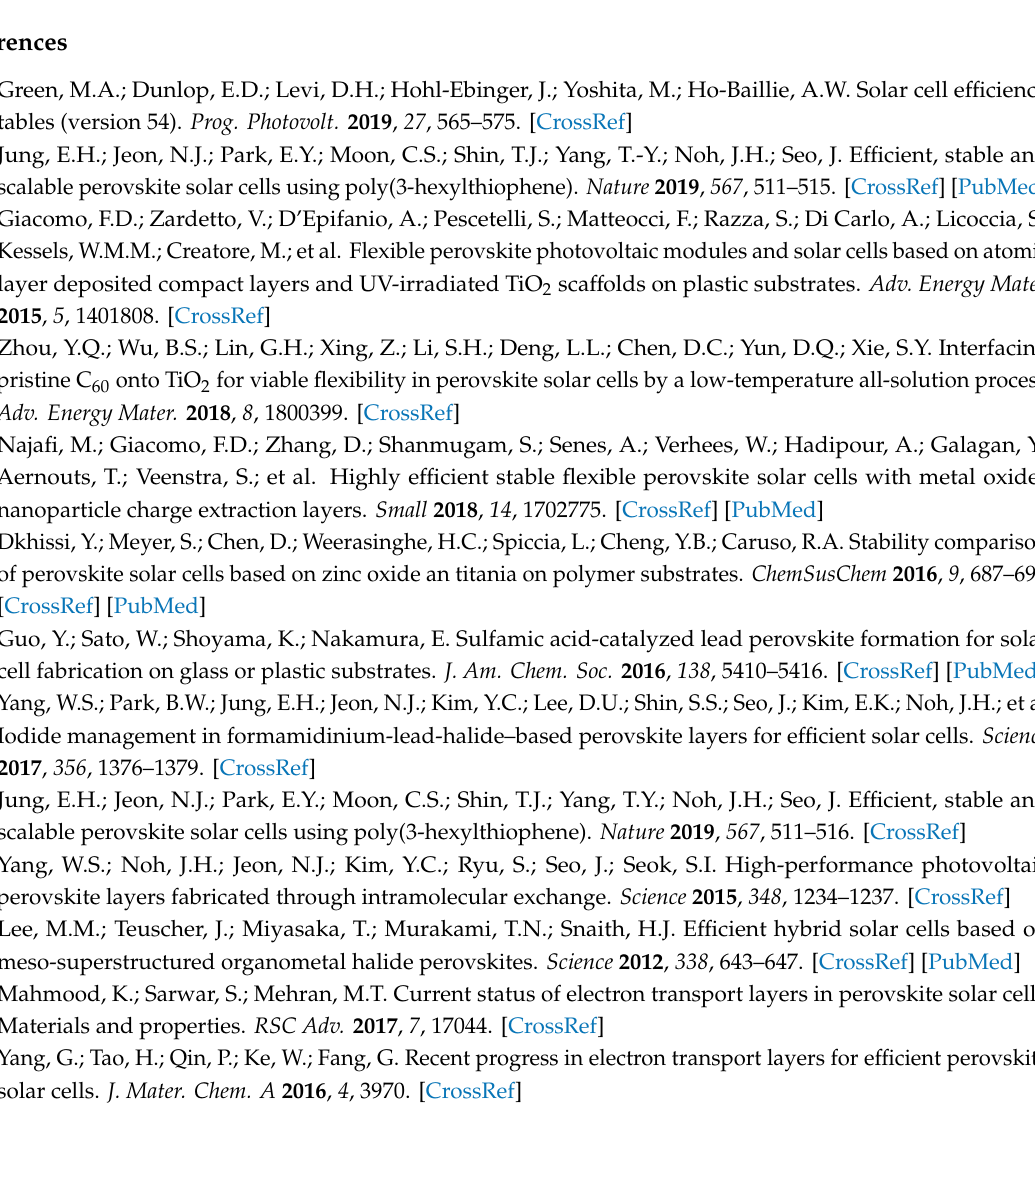
Figure S1: SEM images of the surfaces of single and multilayer TiO 2 , Figure S2: Current–voltage curves and photovoltaic characteristics of perovskite solar cells based on single and multilayer TiO 2 . Author Contributions: S.J. conceived and designed the research. E.-J.S. and J.-D.K. participated in the fabrication of the thin film of TiO 2 on PEN substrates. J.N. and I.N. participated in materials preparation, device fabrication, and data interpretation. S.J. and J.N. wrote the paper. S.J. supervised the project. All authors discussed the results and commented on the